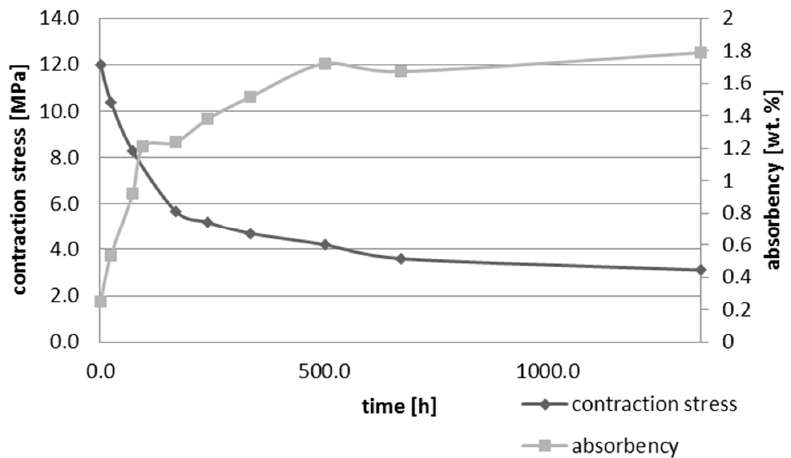
Figure 2. The influence of water sorption (28 days water immersion) on absorbency and contraction stress generated during photopolymerization of Grandia Direct LoFlo.